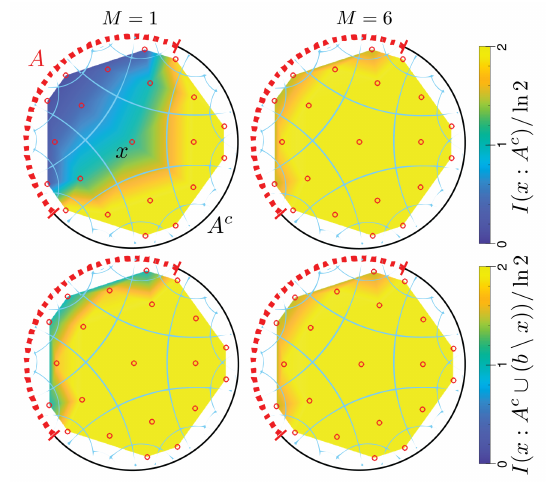
Figure 16 . The precise location of the ETW brane in the HaPPY code is “fuzzy” in the M = 1 case (left column) due to residual entanglement between bulk qubits after measurement and the non-maximal mutual information between some bulk qubits and the boundary A c . By contrast, the brane can be unambiguously located in the M = 6 case (right column). Here we plot the average bulk-boundary mutual information I ( x : A c ) (top row) and the average bulk-inclusive mutual information I ( x : A c ∪ ( b \ x ))) , sampled over 10 3 randomly-chosen LPMs performed on the boundary region A . Note that in the M = 6 case the results obtained for I ( x : A c ) and I ( x : A c ∪ ( b \ x ))) are nearly identical, indicating that the ambiguity in the ETW brane definition is suppressed in this analogous large- N limit.